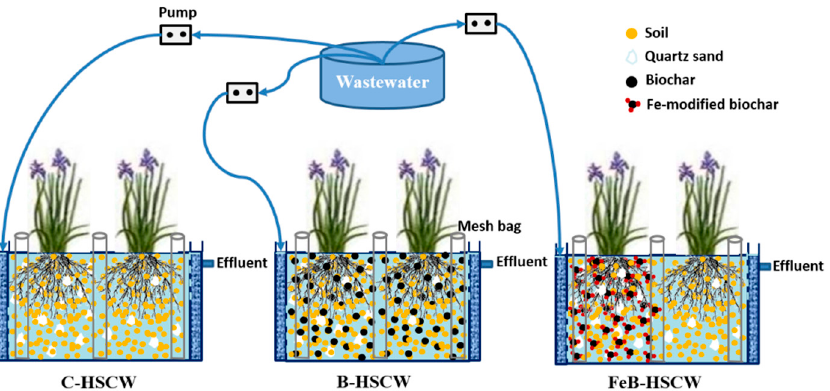
Figure 1. The schematic diagram of constructed wetlands (HSCWs) with different substrates. C- HSCW, without biochar and FeB-modified biochar; B-HSCW, with biochar; FeB-HSCW, with FeB- modified biochar.